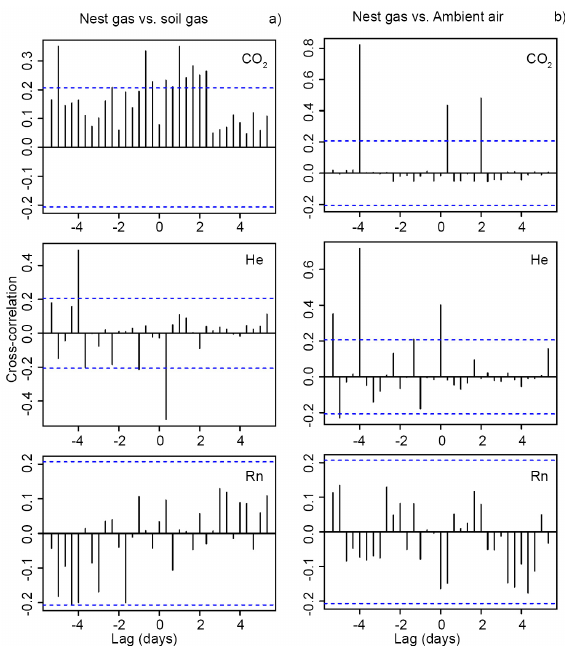
Figure 4. Cross-correlations of the time series of ( a ) NG vs. SG mean and ( b ) NG vs. AA for the 4-W samples. Blue dashed lines indicate confidence thresholds.